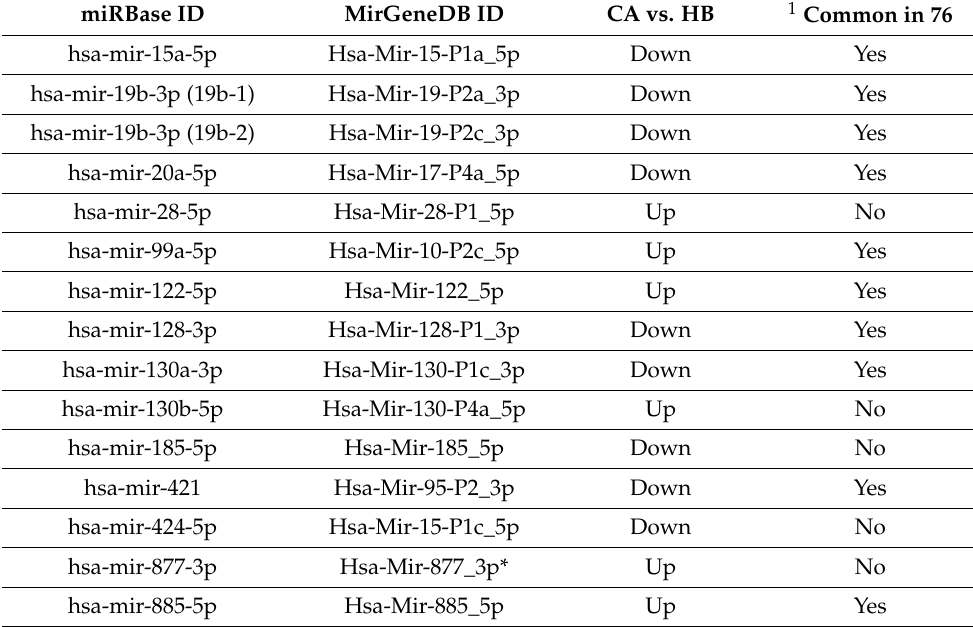
Table 2. Differentially expressed miRNAs in CA vs.